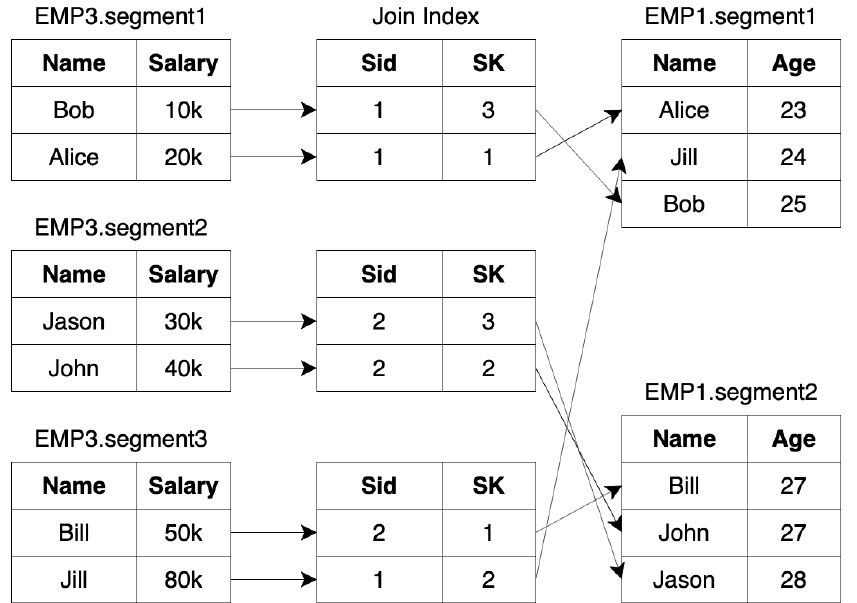
Figure 6. Choosing an index in a joined query. The query optimizer decides the use of an index per joined table per question. Some indexes can exist on a given table, and the optimizer chooses one of